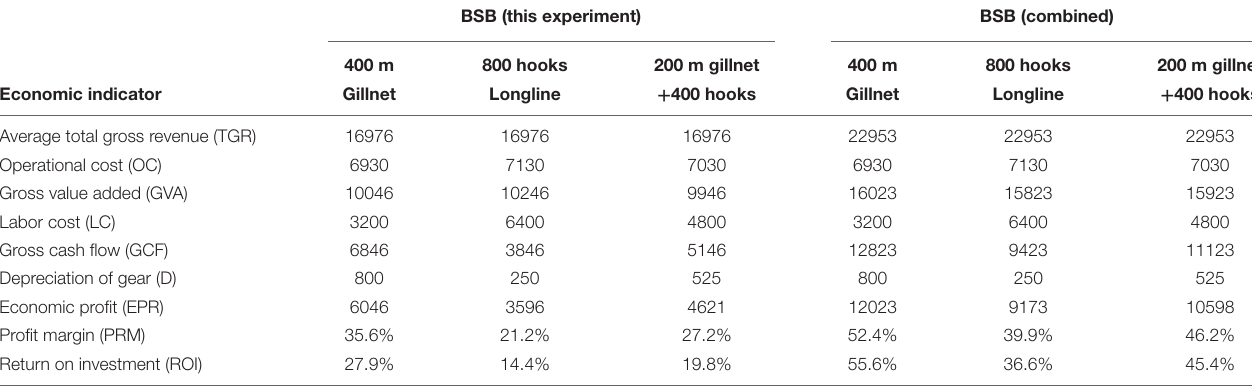
TABLE 7 | Analysis of the economic indicators (in kg of fish equivalent), based in fish catch rates recorded during this experiment and combined from interviews and Coast Guard reports. BSB (this